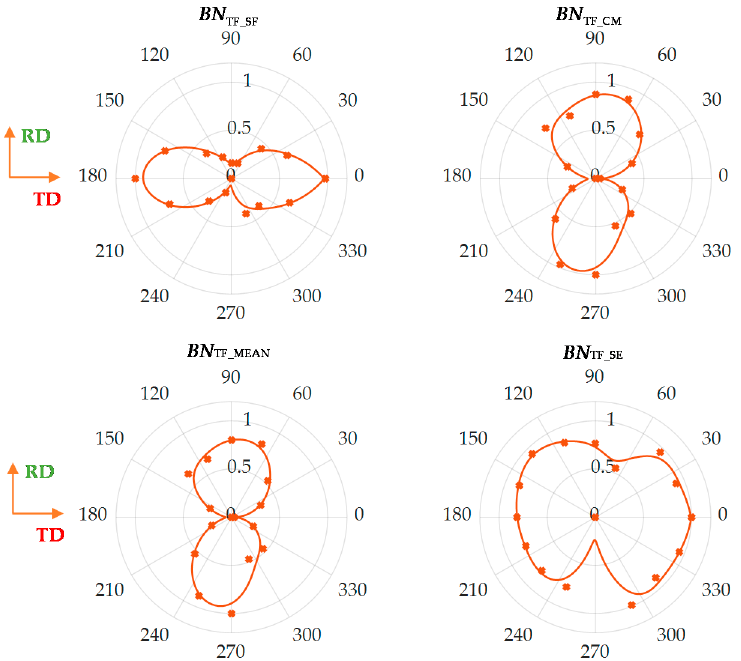
Figure 5. View of calculated parameters for 2 kHz and 512 window size: Markers represents the features values obtained for selected test angles; solid line refers the piecewise fitting result; all results are normalized with respect to maximum value.